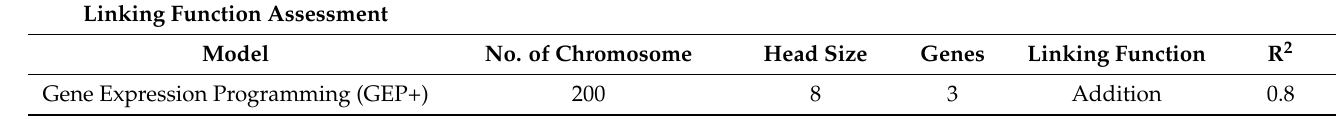
Table 1. Parameters of GEP models used for Ti concentration vs. temperature